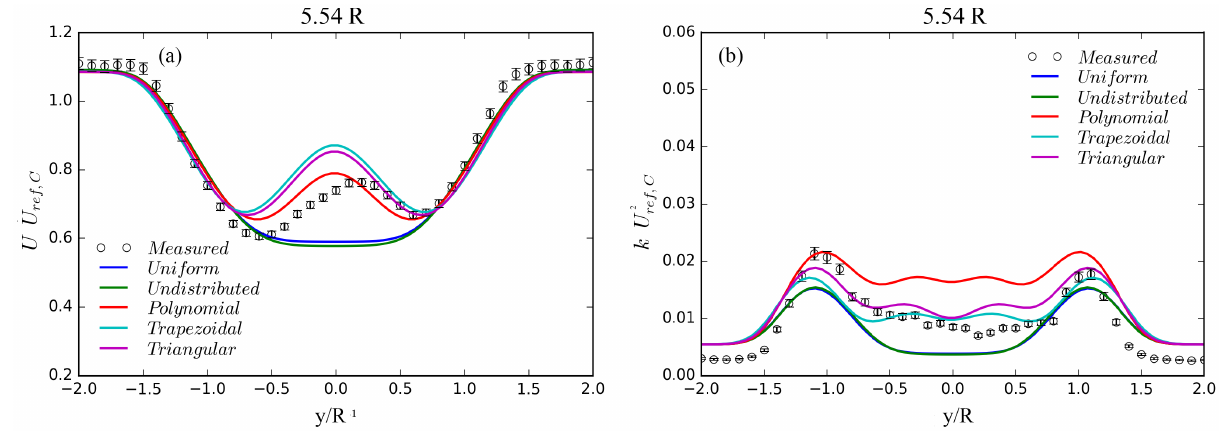
Figure 14. (a) Normalized axial velocity and (b) normalized turbulence kinetic energy computed for the two in-line model wind turbines (case C2) at x/R = 5 . 54 downstream of the first wind turbine. Different thrust distributions and the k - ε turbulence model are used.